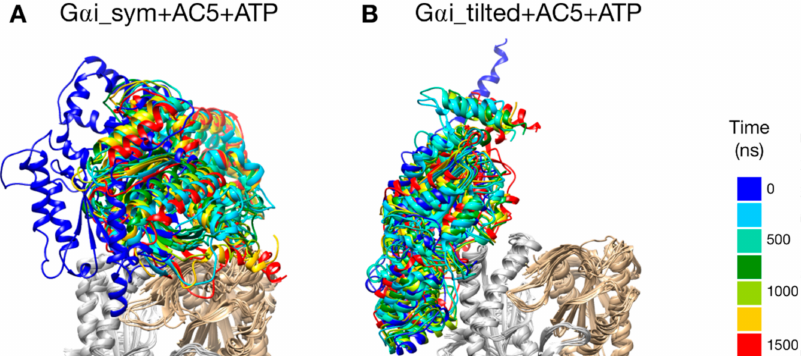
Figure 4. Snapshots of the G α i + AC5 + ATP complexes observed during the simulations, viewed from the membrane side. G α i structures extracted every 250 ns are colored on a rainbow scale from blue to red. The C1 domain of AC5 is colored in gray and the C2 domain in